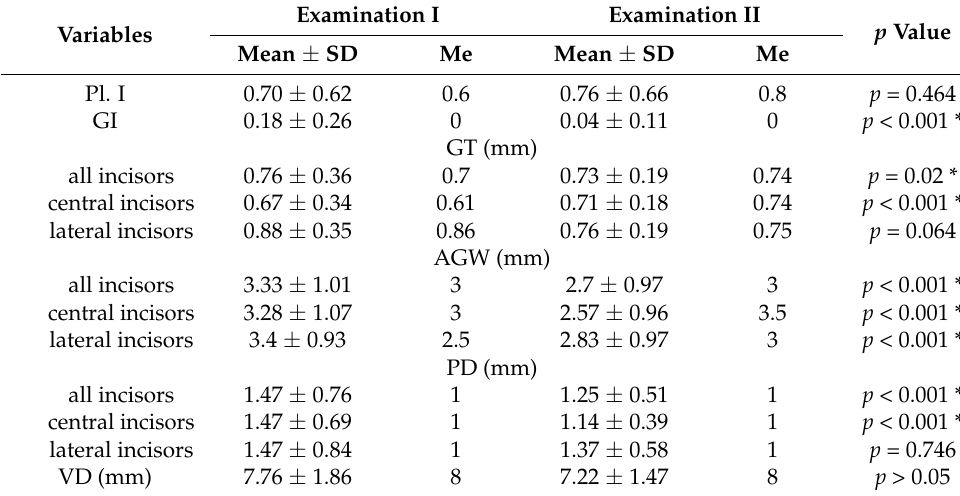
Table 1. Changes in the measured parameters.